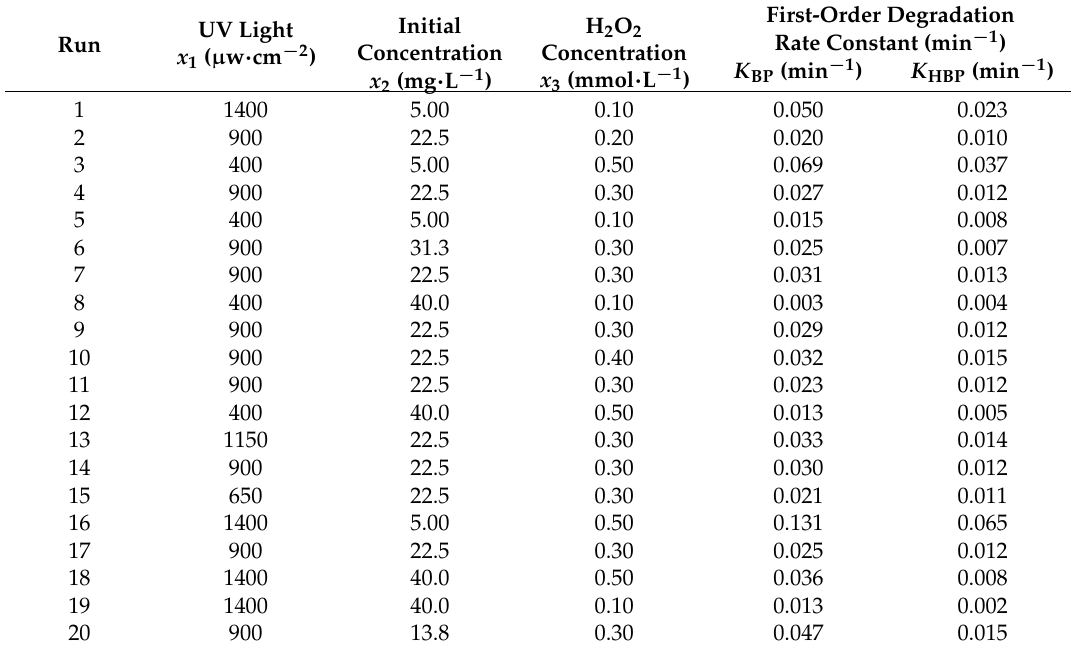
Table 2. Expert design together with the observed experimental